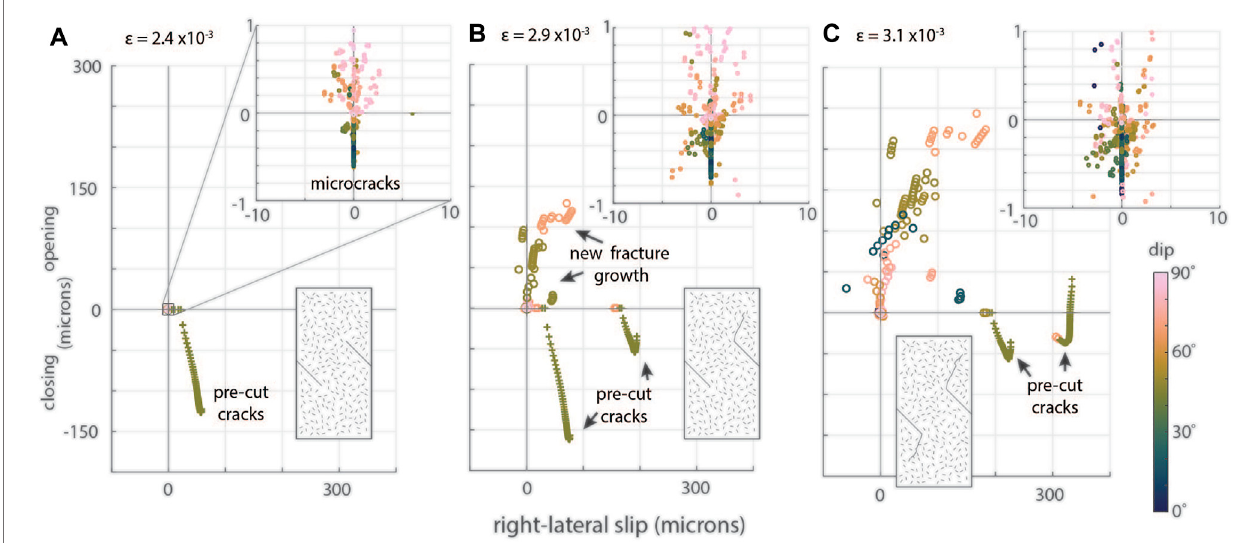
FIGURE 7 | (A) Slip and closing/opening for each element in the model prior to new fracture growth from the tips of the preexisting cracks, at strain 2.4e-3. Inset shows values for microcracks clustered around the origin. Each point is color-coded by dip angle from 0 ° (horizontal) to 90 ° (vertical). (B) Slip and closing/opening on model elementsafter fracturegrowth atastrainof2.9e-3. (C) Slipand closing/openingonmodelelementsafter fracturegrowth atastrainof3.1e-3.Asstrainincreases, fracture growth from one pre-cut crack promotes increased slip and decreased closing, while the pre-cut crack that does not grow exhibits more closing and only slightly more slip. New fracture growth is all opening mode and mixed-mode opening and shear, with mostly right-lateral slip. Increased strain increases slip, opening, and closing on microcracks (insets).